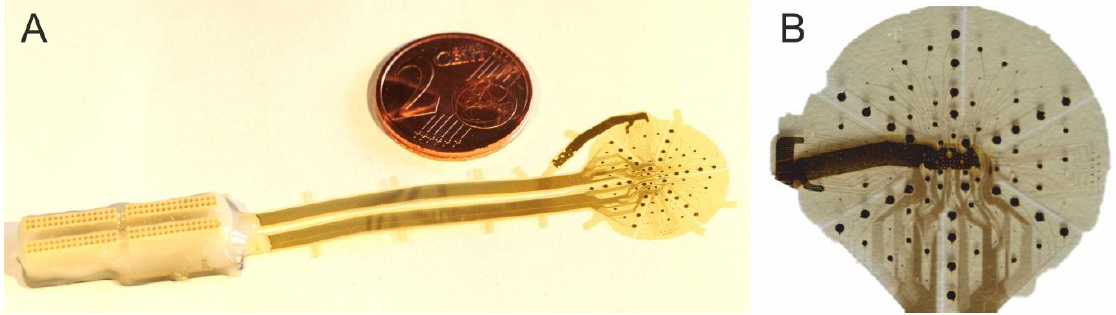
Figure 10. ( A ) ECoG array after wafer release; ( B ) The ECoG array with its skull-facing reference